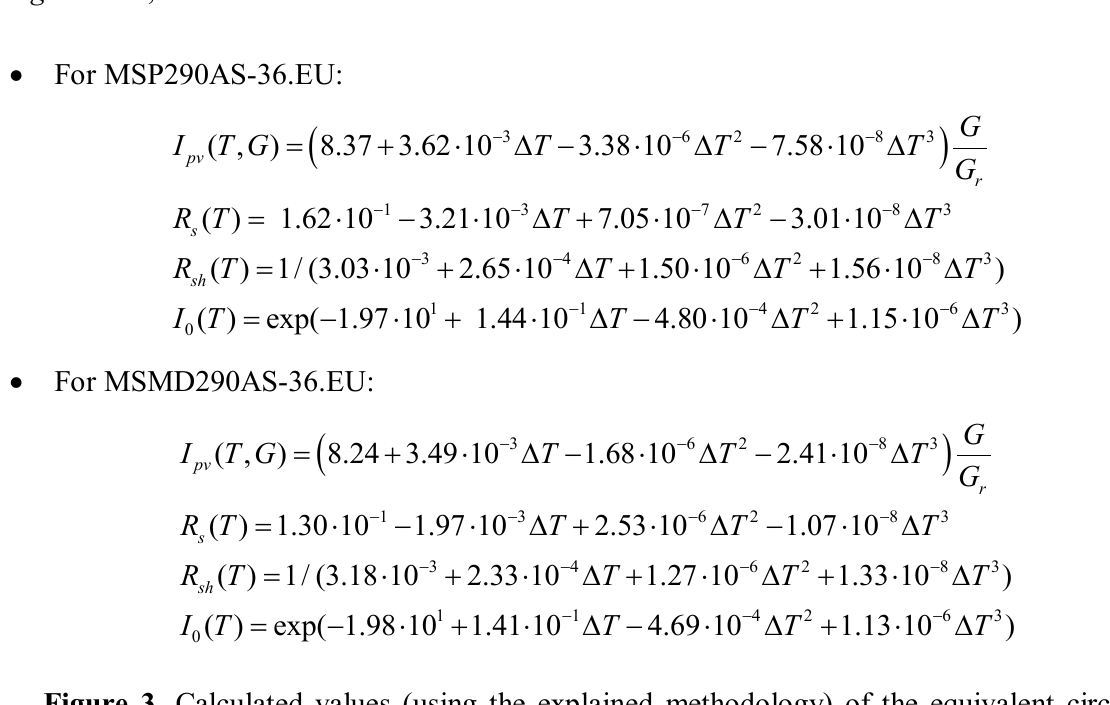
Figure 3. Calculated values (using the explained methodology) of the equivalent circuit parameters R , R , I , and I , for multicrystalline (MSP290AS-36.EU) and monocrystalline s sh pv 0 (MSMD290AS-36.EU) solar cell panels as a function of the temperature, T . Calculated points are indicated with symbols whereas the polynomial approximations fitted to those data (Equations (20) and (21)) have been included in each case as solid